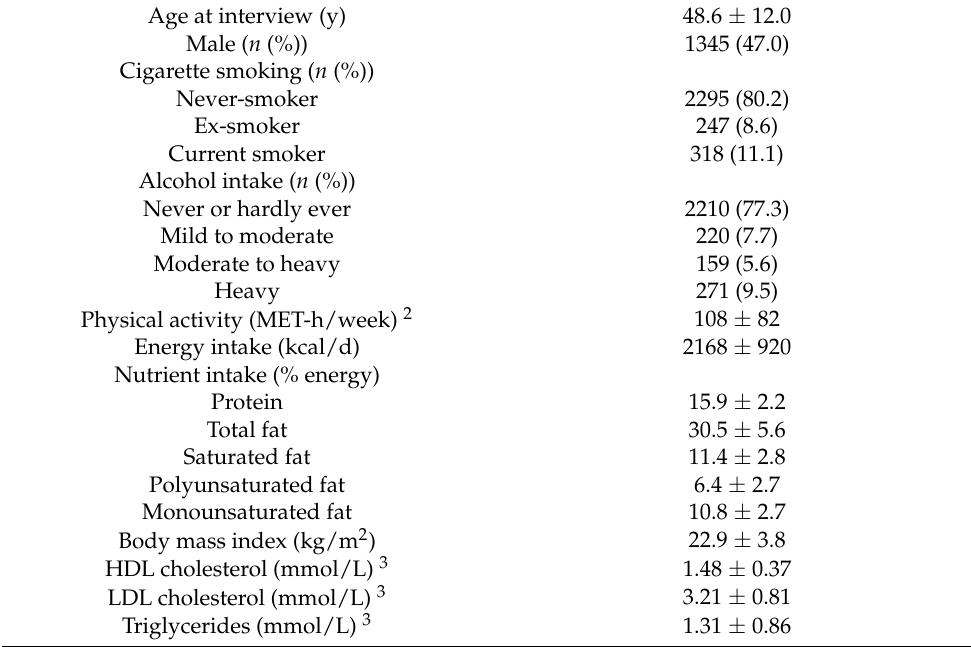
Table 1. Baseline characteristics of study population ( n = 2860) 1